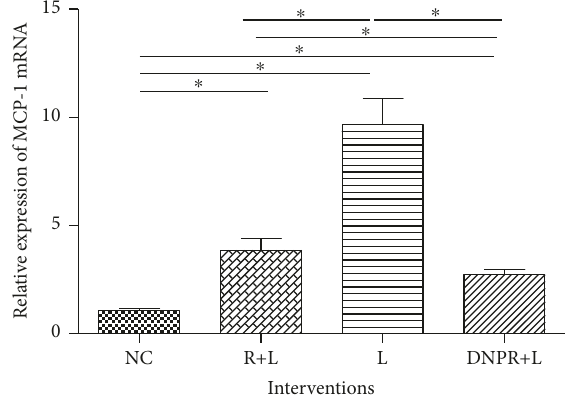
Figure 4: E ff ects of LPS and LPS/CCR2 antagonist interventions on MCP-1 mRNA expression by quantitative real-time